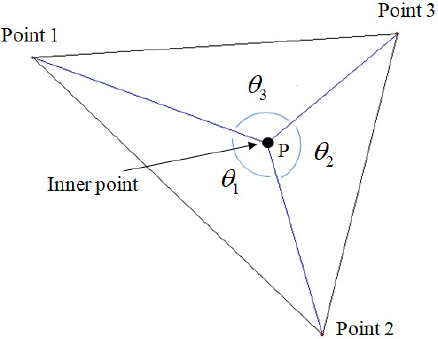
Figure 17. Existence determining method for arbitrary point in a triangular element. Each internal angle can be obtained from the second law of cosine.